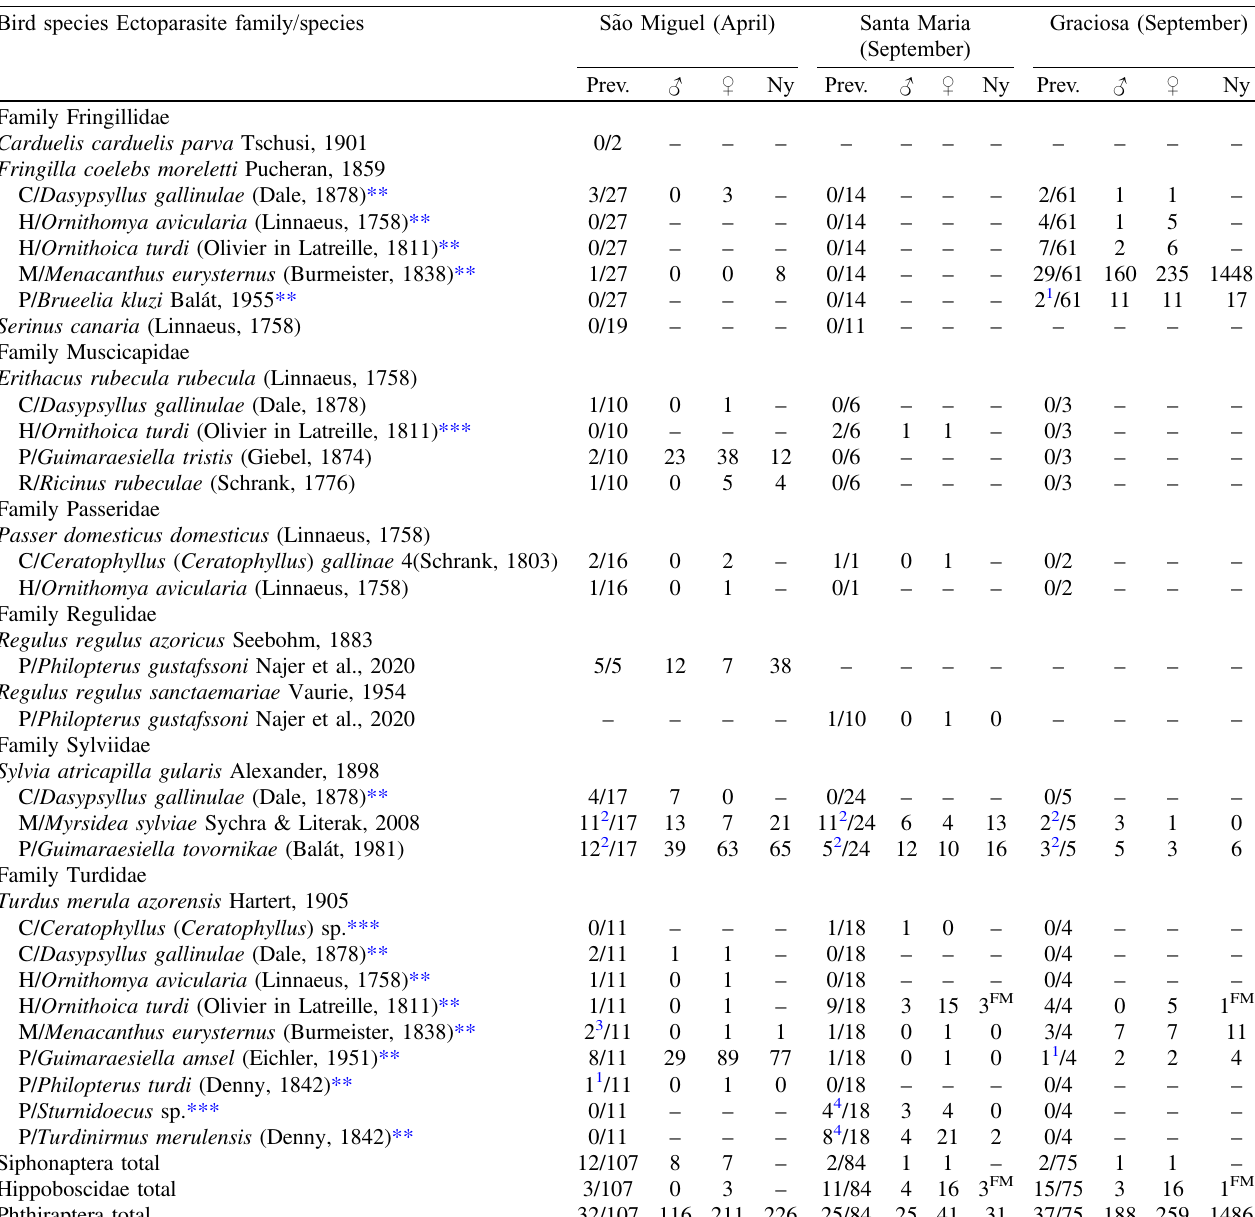
Table 1. List of hosts and their insect ectoparasites. Abbreviation: Prev. = prevalence = number of birds parasitized/number of birds examined, Ny = nymphs, C = Ceratophyllidae, H = Hippoboscidae, M = Menoponidae, P = Philopteridae, R = Ricinidae; FM = gynandromorphs. Bird species Ectoparasite